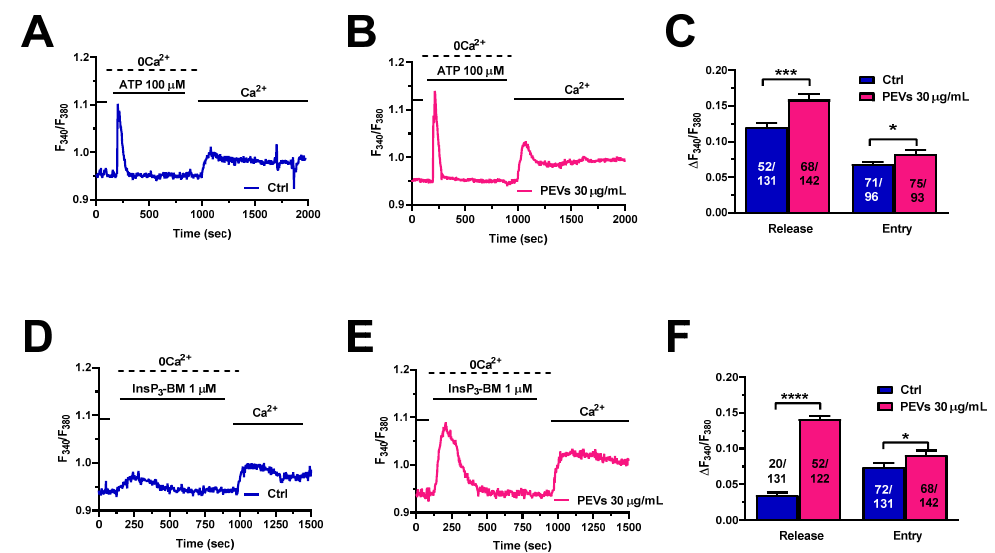
Figure 2. Long-term exposure of MDA-MB-231 cells to PEVs increases InsP 3 -induced ER Ca 2+ mobilization and SOCE. ( A ). ATP (100 µ M) evoked a transient increase in [Ca 2+ ] i under 0Ca 2+ conditions in control (Ctrl) cells. ATP was then removed from the recording bath, while extracellular Ca 2+ was restored to the solution to measure SOCE. ( B ). The treatment of MDA-MB-231 cells with PEVs (30 µ g/mL, 24 h) increased ATP-induced endogenous Ca 2+ mobilization and SOCE activation. ( C ). Mean ± SEM of ATP-induced intracellular Ca 2+ release and SOCE in control (Ctrl) and PEV-treated cells. * indicates p < 0.05 and *** indicates p < 0.001. ( D ). InsP 3 -BM, a membrane-permeant esterified form of InsP 3 , induced a small increase in [Ca 2+ ] i under 0Ca 2+ conditions in control (Ctrl) cells. Restoration of extracellular Ca 2+ , in the absence of the agonist, caused a second bump in [Ca 2+ ] i that was indicative of SOCE activation. ( E ). The treatment of MDA-MB-231 cells with PEVs (30 µ g/mL, 24 h) caused an enhancement in intracellular Ca 2+ mobilization and SOCE in MDA-MB-231 cells stimulated with InsP 3 -BM. ( F ). Mean ± SEM of InsP 3 -BM-induced endogenous Ca 2+ mobilization and SOCE in control (Ctrl) and PEV-treated cells. **** indicates p < 0.0001 and * indicates p < 0.05.